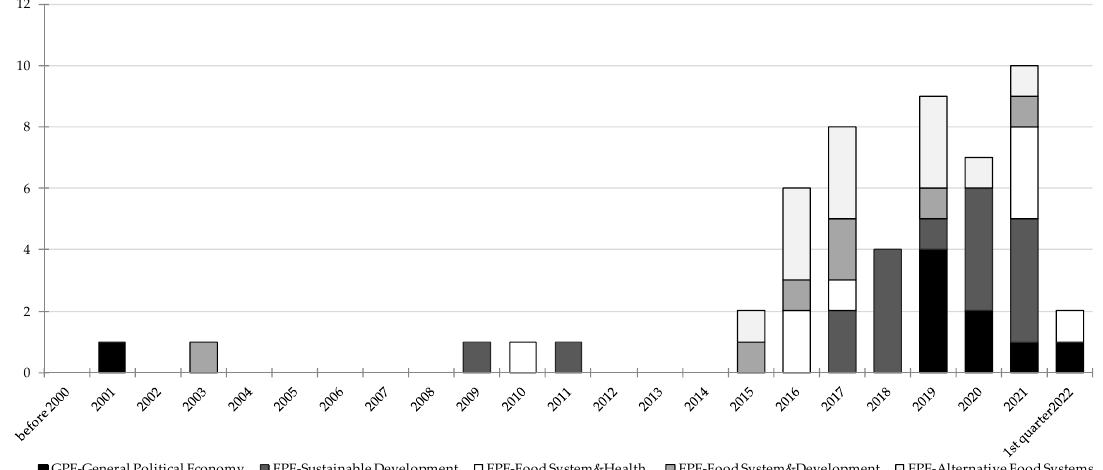
Figure 3. Group of Political Economy studies (53 records)—year of publication and main topics.